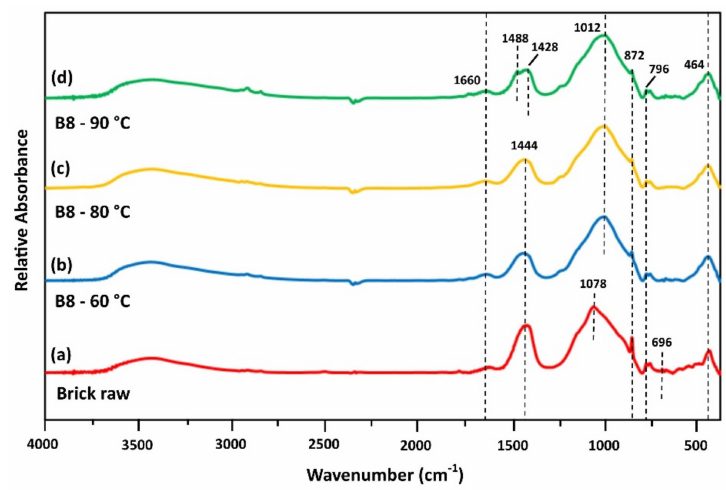
Figure 4. FTIR spectra of ( a ) brick as raw material and brick-based IPs produced after curing at ( b ) 60 ◦ C, ( c ) 80 ◦ C and ( d ) 90 ◦ C (H 2 O / Na 2 O = 18.2; aged for 7